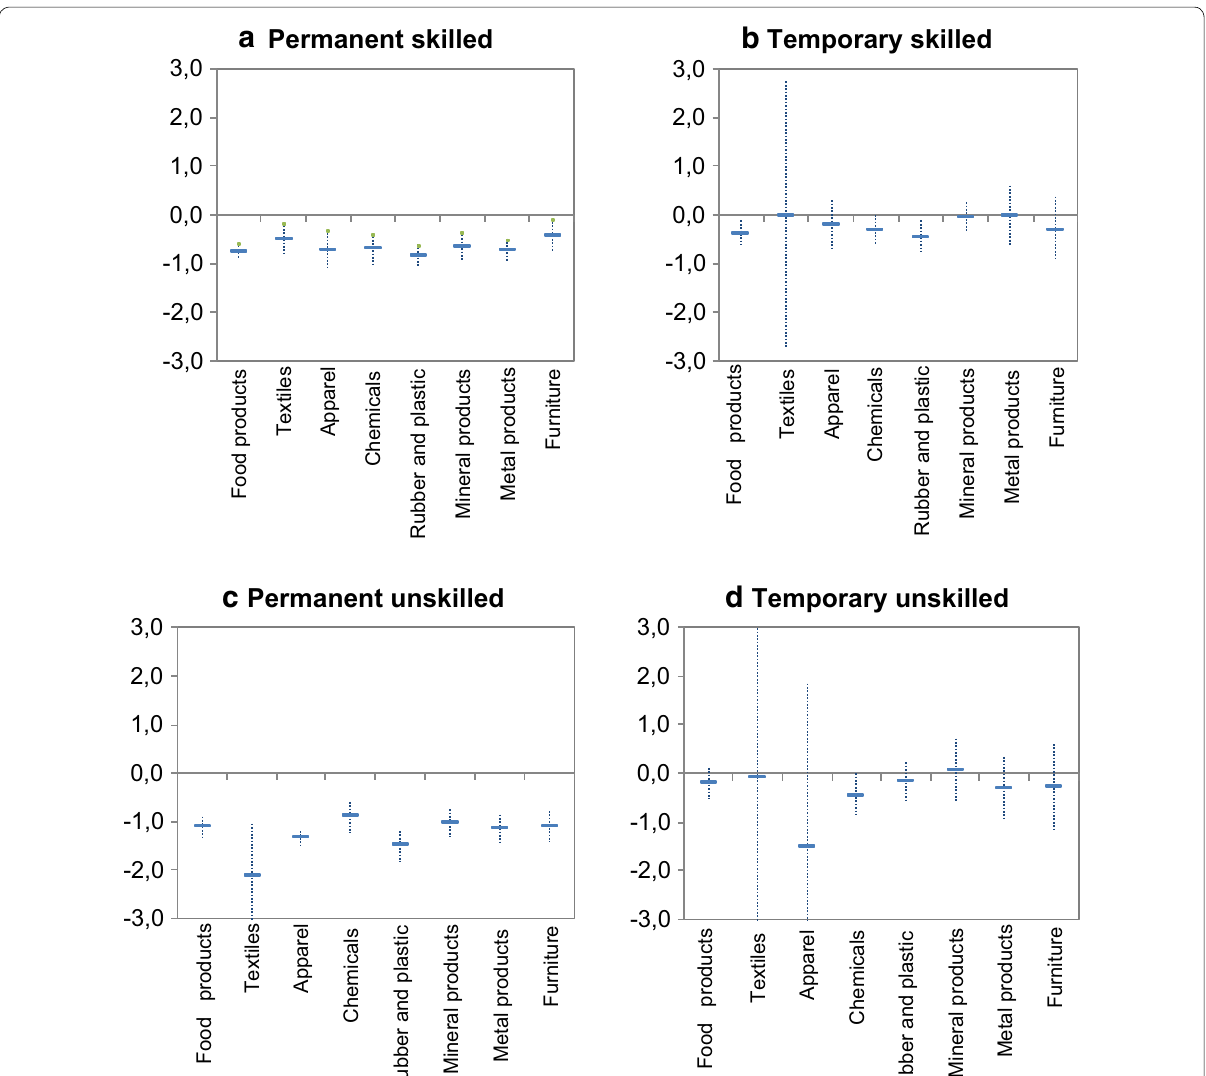
Fig. 7 Long-run own-price elasticity of conditional labour demand (2000–2013). 95% confidence intervals ( Source Dane-AMS and authors’